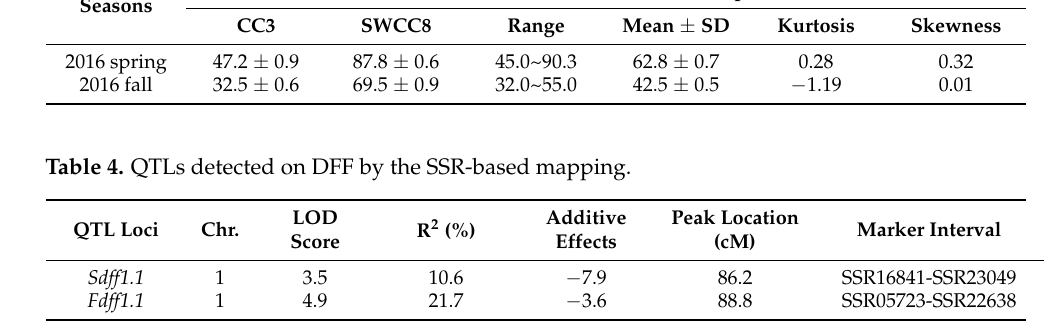
Table 3. Phenotypic variation of DFF in the RIL 9 population at 2016 spring and fall. Parents Seasons